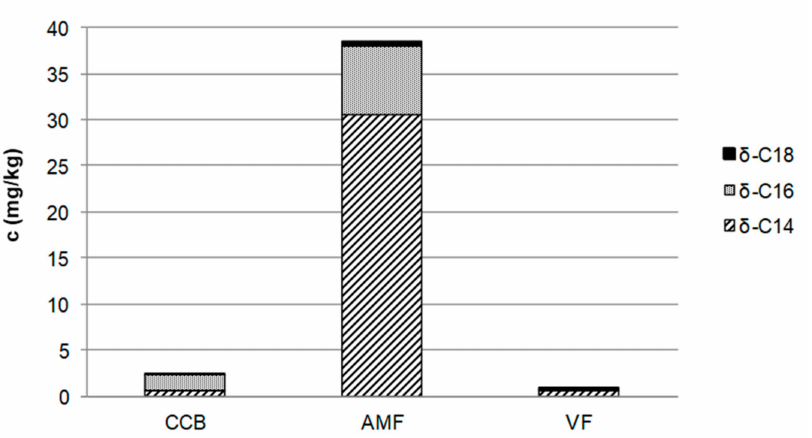
Figure 3. Concentrations of δ -tetra- ( δ -C14), δ -hexa- ( δ -C16), and δ -octadecalactone ( δ -C18) in cocoa butter (CCB), anhydrous milk fat (AMF), and vegetable fat (VF) after removal of triglycerides determined by means of LC–MS/MS. (SD < 10%).